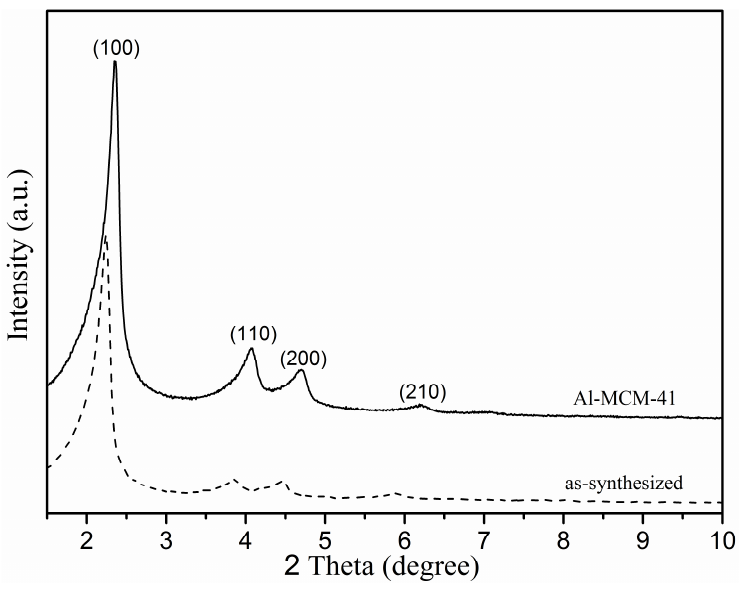
Figure 1. Small-angle X-ray diffraction ( SAXRD) patterns of as-synthesized samples (ASSs) and Al–MCM–41.